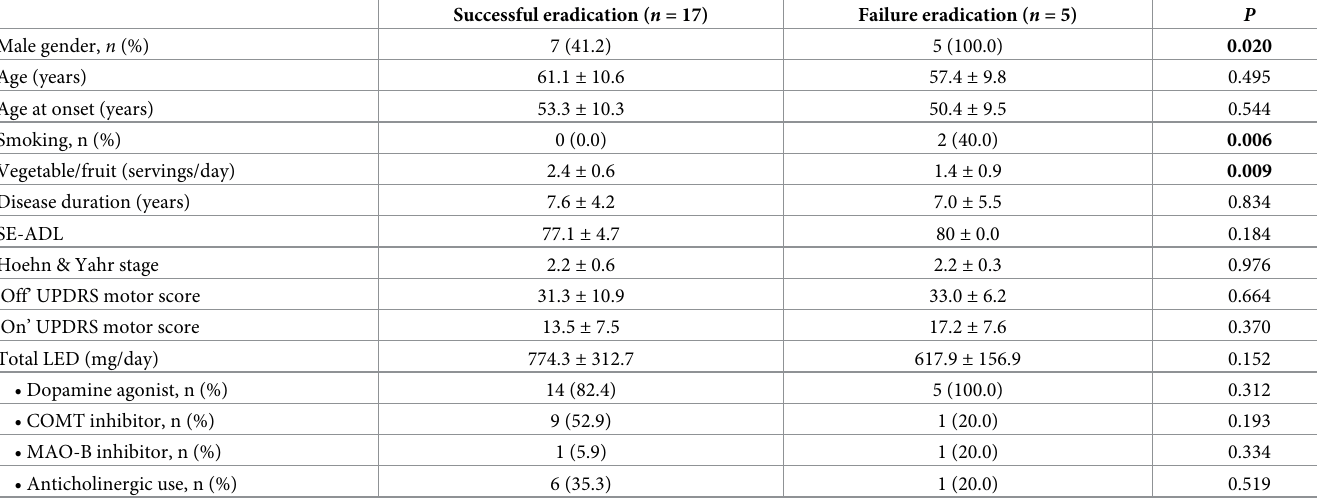
Table 5. Demographic and clinical baseline status between Helicobacter pylori (HP) positive patients who succeeded and failed the eradication